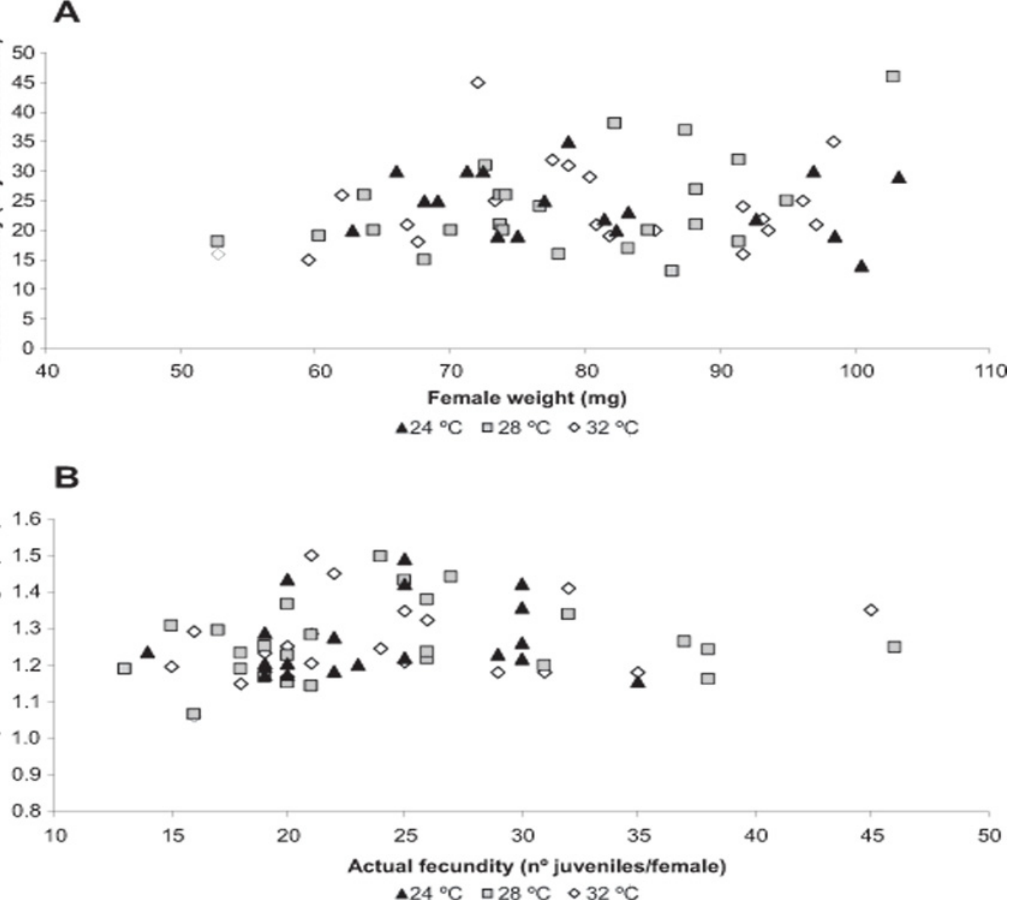
Fig 2. Relationship between actual fecundity and female weight (A) and between juvenile initial cephalothorax length and actual fecundity (B). Neocaridina heteropoda heteropoda females were kept at three different water temperatures (24, 28 or 32°C) over the incubation period, from the spawning day to the hatching day. The number of females per treatment was 19 at 24°C, 26 at 28°C and 20 at 32°C. No statistical relationships were found between the variables analyzed ( P > 0.05).